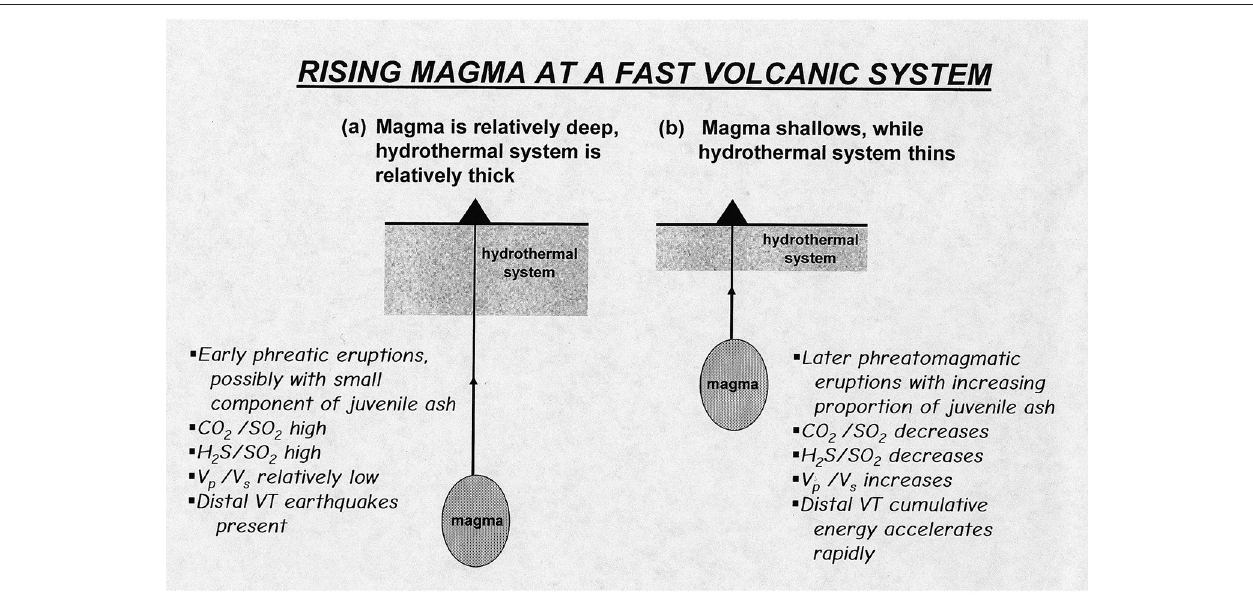
FIGURE 8 | A conceptual depiction of geochemical and geophysical change associated with rising magma at a volcano with fast activity. The hydrothermal system thins as the shallowing magma dries it.